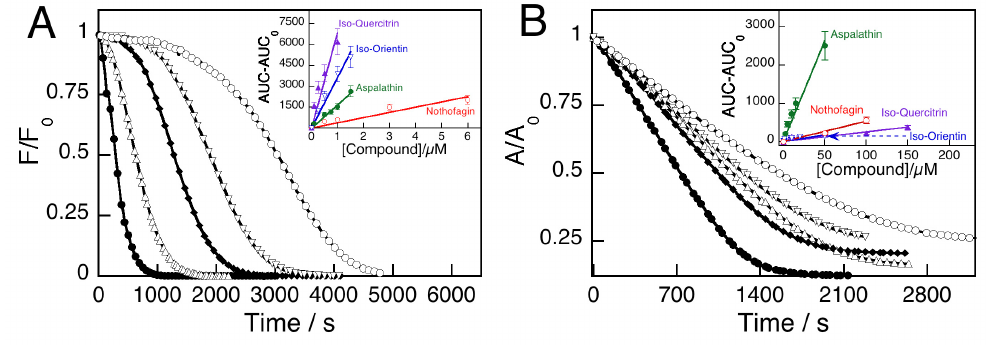
Figure 1. Effect of Asp on fluorescein (70 nM) decay (A) or pyrogallol red (18 µM) bleaching (B) promoted by 10 mM AAPH at 37 °C. Concentration of Asp, A: (  ) control, (  ) 0.1 µM; (  ) 0.5 µM; (  ) 1.0 µM and 1.5 µM (  ) and B: (  ) control, (  ) 2.5 µM; (  ) 5.0 µM; (  ) 10 µM and 15 µM (  ). Insets: Change in the area under the curve (AUC) at increasing concentrations, in µM, of selected pure polyphenols (A and B). All measurements were carried out in 75 mM phosphate buffer pH 7.4 at 37 ± 0.5 °C. ORAC indices listed in Table 1 were calculated from the linear fit of the AUC vs. concentration curve as shown in the insets.